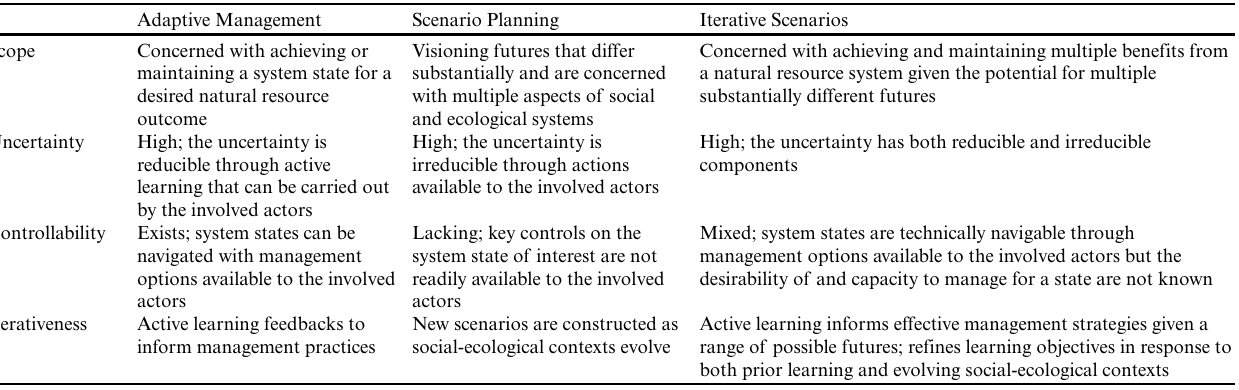
Table 1 . Iterative scenarios combines aspects of adaptive management and scenario planning into a new management